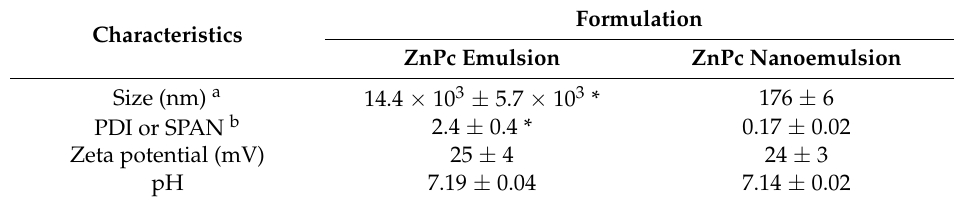
Table 2. Physicochemical characteristics of emulsion and nanoemulsion dispersed in PBS containing about 4.5 µg/mL of ZnPc.